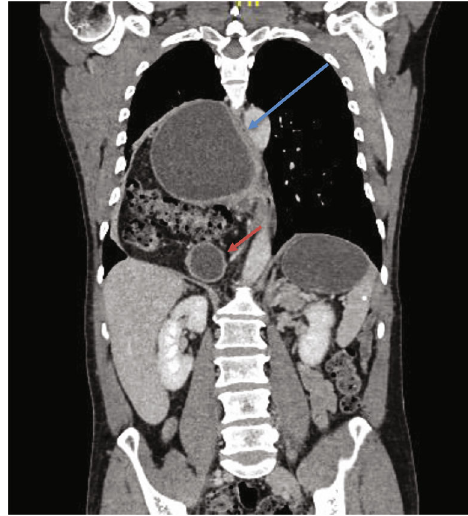
Figure 1: Computed tomography of the thorax, abdomen, and pelvis. Coronal reconstruction showing a giant HH involving the stomach and part of the duodenum and transverse colon. The blue arrow corresponds to the esophagus compressed by the hiatal hernia; the red arrow corresponds to the duodenum.